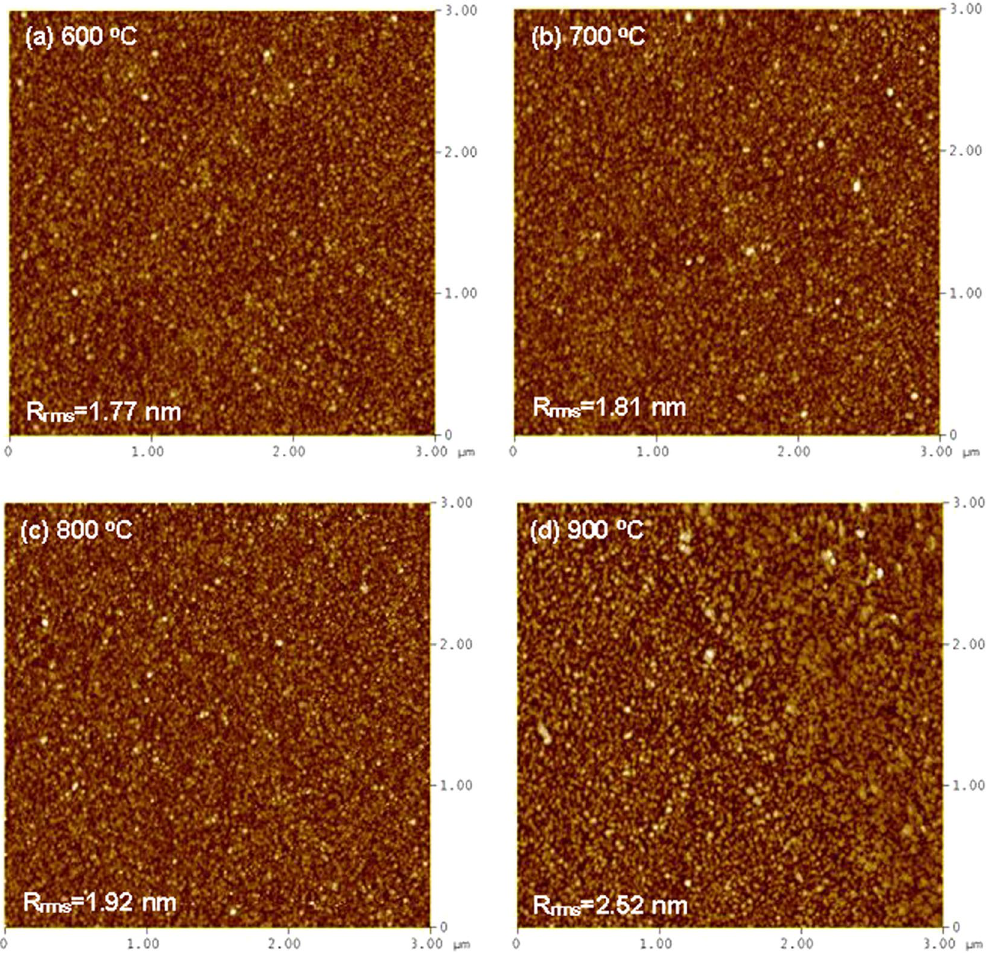
Figure 3. AFM surface images of CeY x O y sensing films that had been annealed at ( a ) 600, ( b ) 700, ( c ) 800, and ( d ) 900